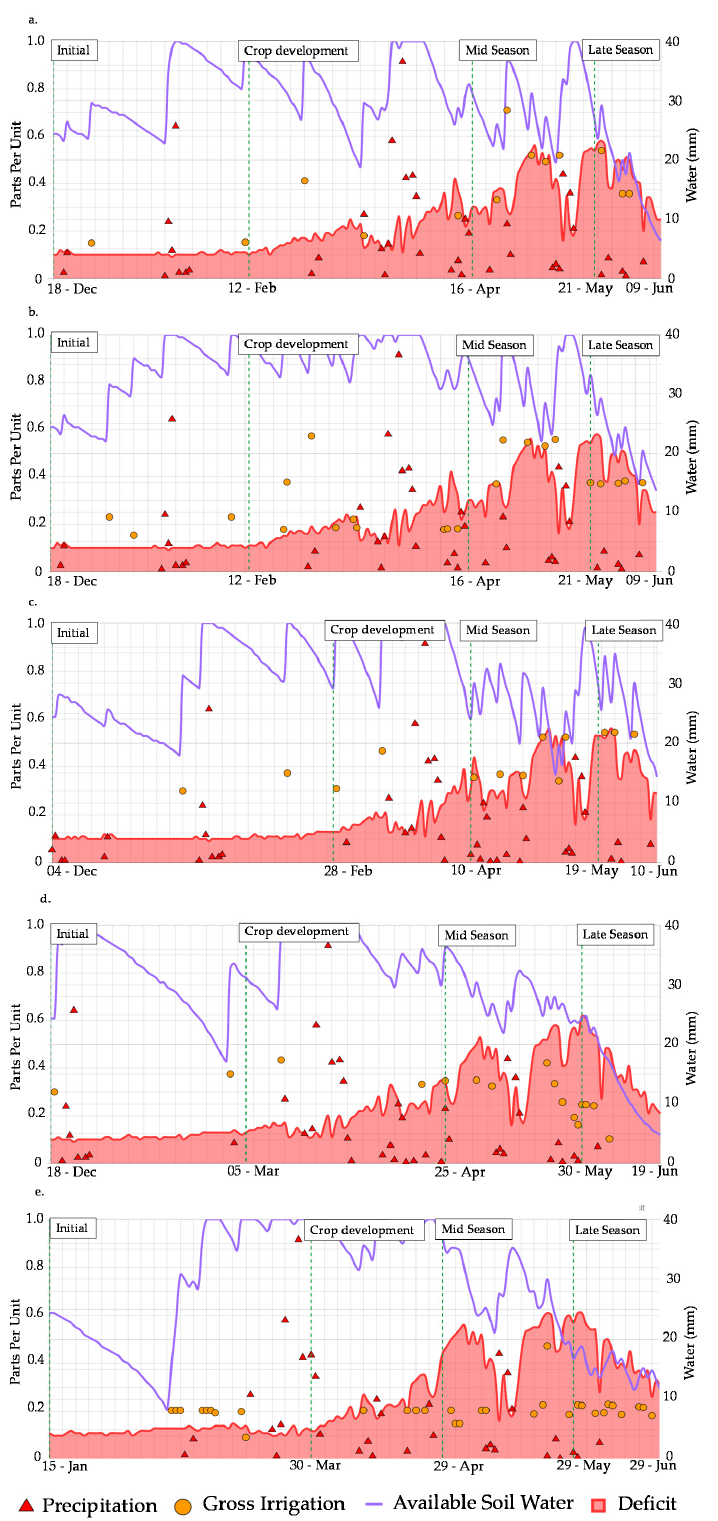
Figure 2. Evolution of available water simulated by “MOPECO irrigation scheduling” tool in 2020 ( a ): SUP, SUP: Supromed management; ( b ) LEA: Leader management; ( c – e ): AVE: Average management. Main Y axis: deficit: 1-p, where p is the fraction of total available water (TAW) that a crop can extract without suffering water stress; available water. Secondary Y axis: gross irrigation;